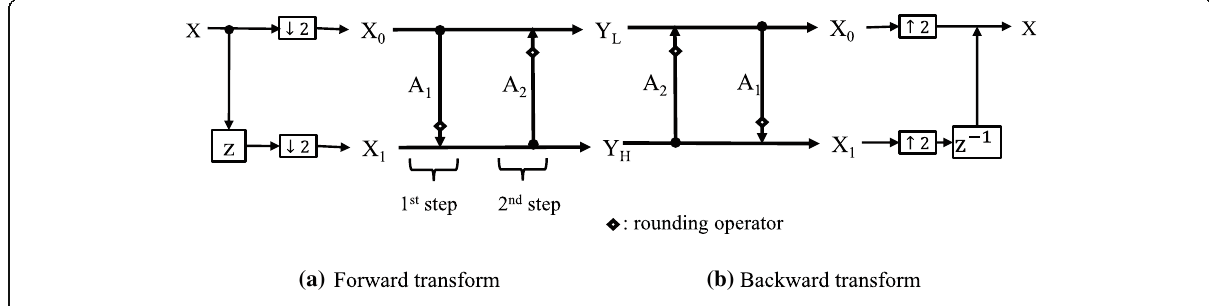
Fig. 1 The 1D integer WT for 5/3-type transform. a Forward transform. b Backward transform